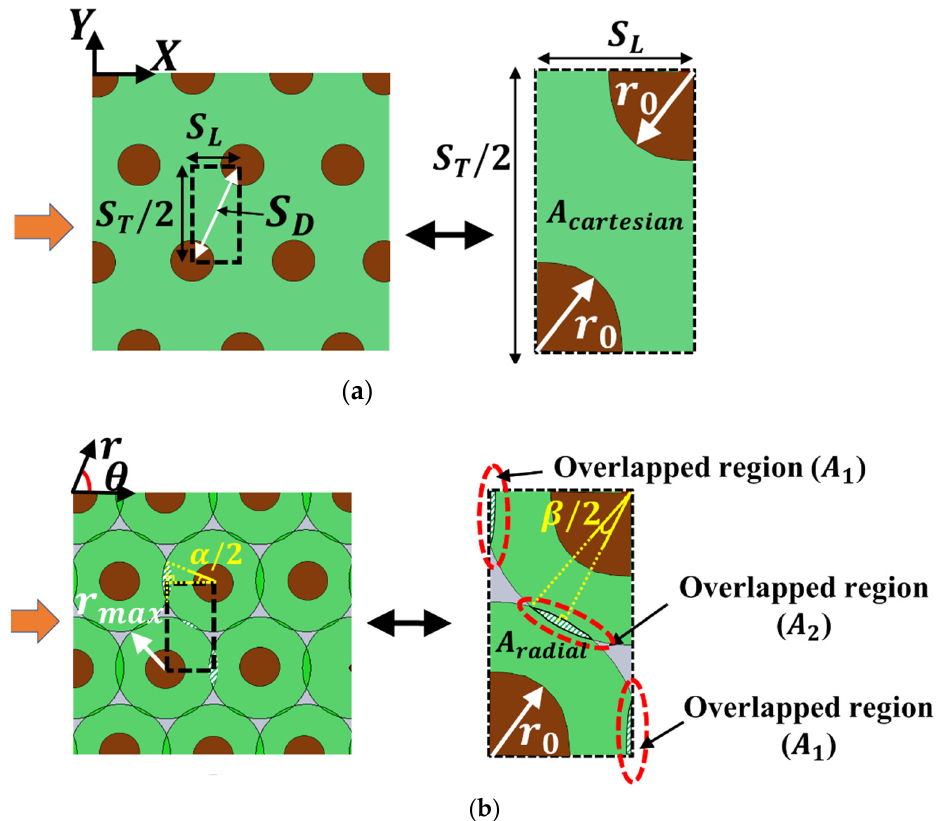
Figure 4. Comparing thermal masses for ( a ) Cartesian and ( b ) radial PCM domains for neighboring wires with overlap regions 𝐴 (cid:2869) and 𝐴 (cid:2870) marked in dashed ‐ border circles.